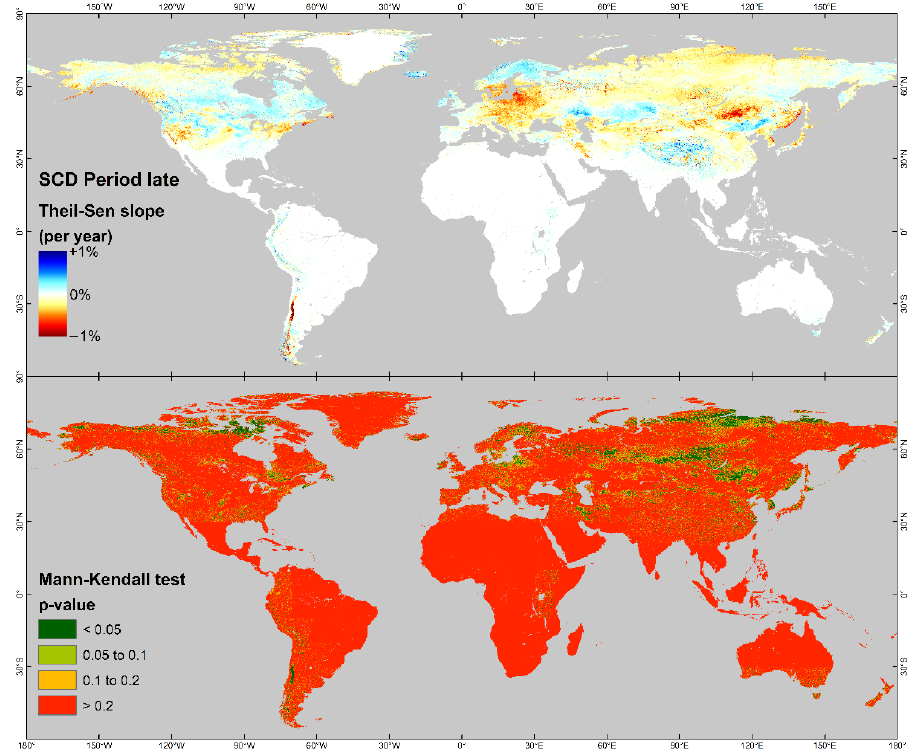
Figure 10. Pixel-based development of SCD in the late snow season. The Theil–Sen slope is shown above and the associated p -values are shown below.